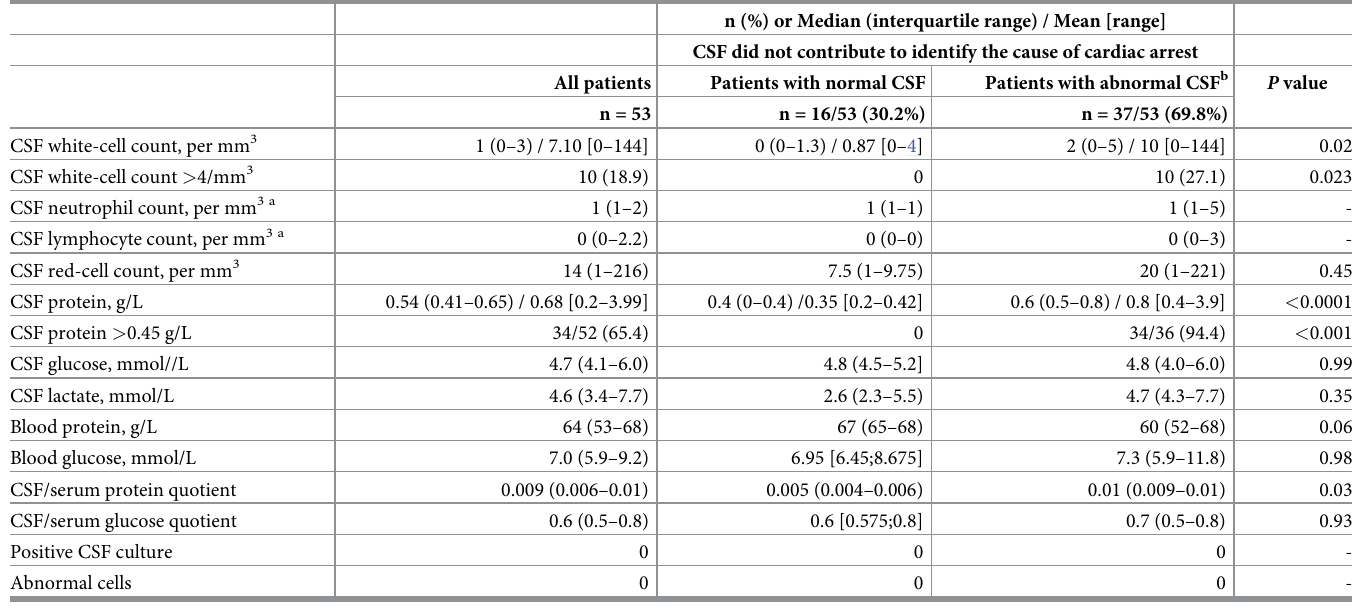
CSF: cerebrospinal fluid a in patients with CSF white-cell count > 4/mm 3 b Abnormal CSF was defined as CSF white-cell count > 4/mm 3 and/or CSF protein > 0.45